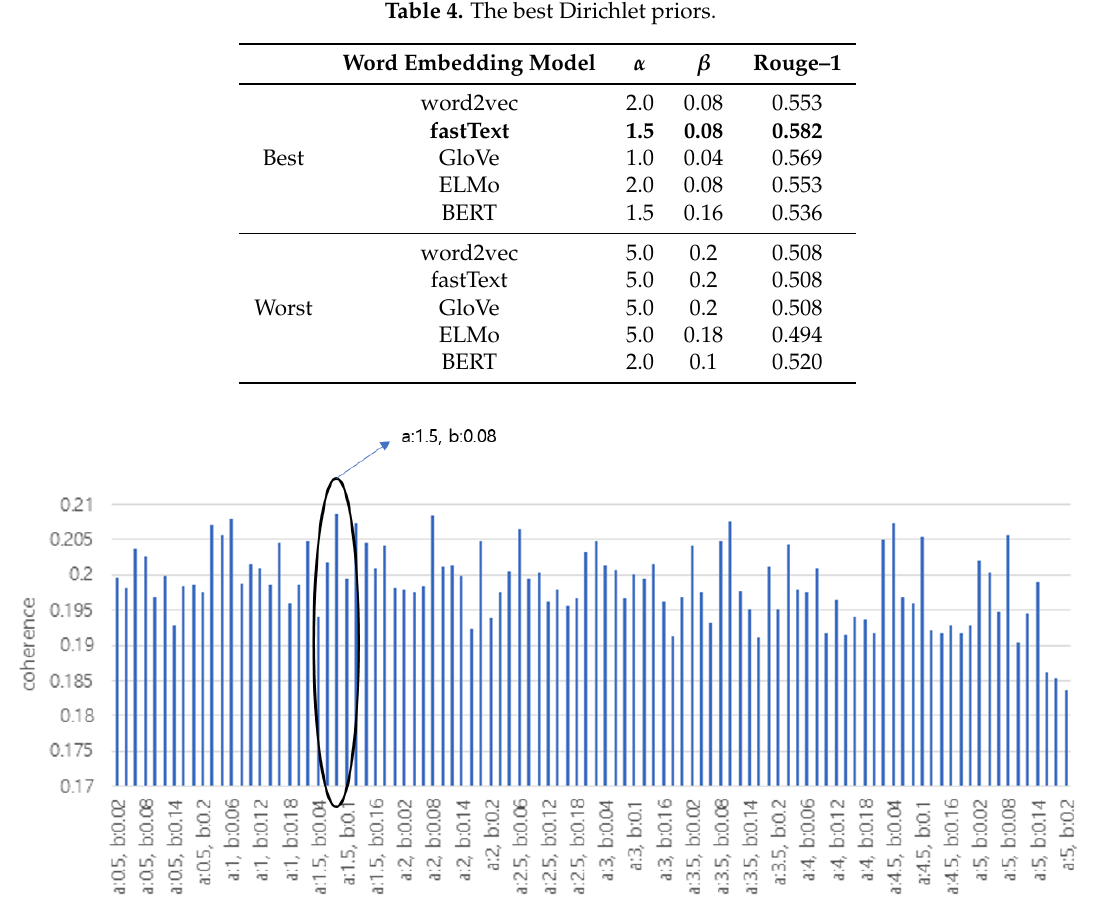
Figure 3. Average topic coherence values of Algorithm 1 according to different α and β values (In the figure, α and β are represented as a and b